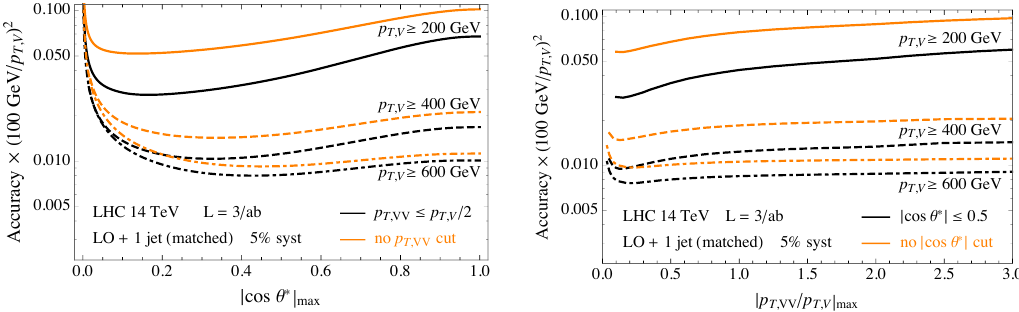
j (left panel) and (cid:3)